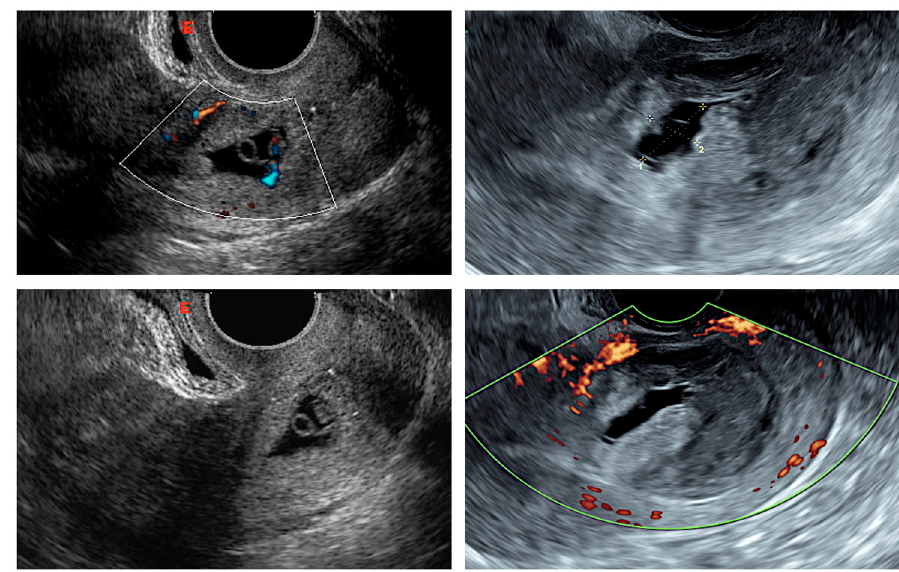
Figure 1. Transvaginal sonographic views of cesarean scar pregnancy.